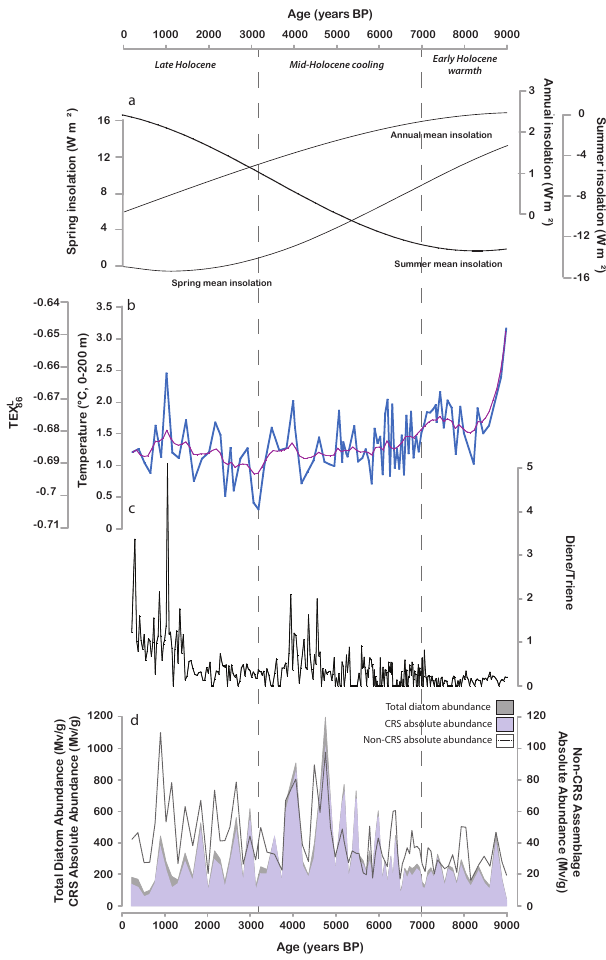
Fig. 3. Paleoclimatic proxies from core JPC-10 compared with Holocene insolation. (a) Annual, summer and spring mean insola- tion at 65 ◦ S (Berger and Loutre, 1991), (b) TEX L perature ( ◦ C, 0–200m) record (blue) and the smoothed curve (red), (c) the D/T ratio and (d) the total diatom abundance (Mvg − 1 ), the CRS absolute abundance (Mvg − 1 ) and the non-CRS assemblage absolute abundance (Mvg − 1 ). The two vertical solid dashed grey lines denote the early Holocene warmth, mid-Holocene cooling and late Holocene periods, following the reconstructed TEX L atures trend.